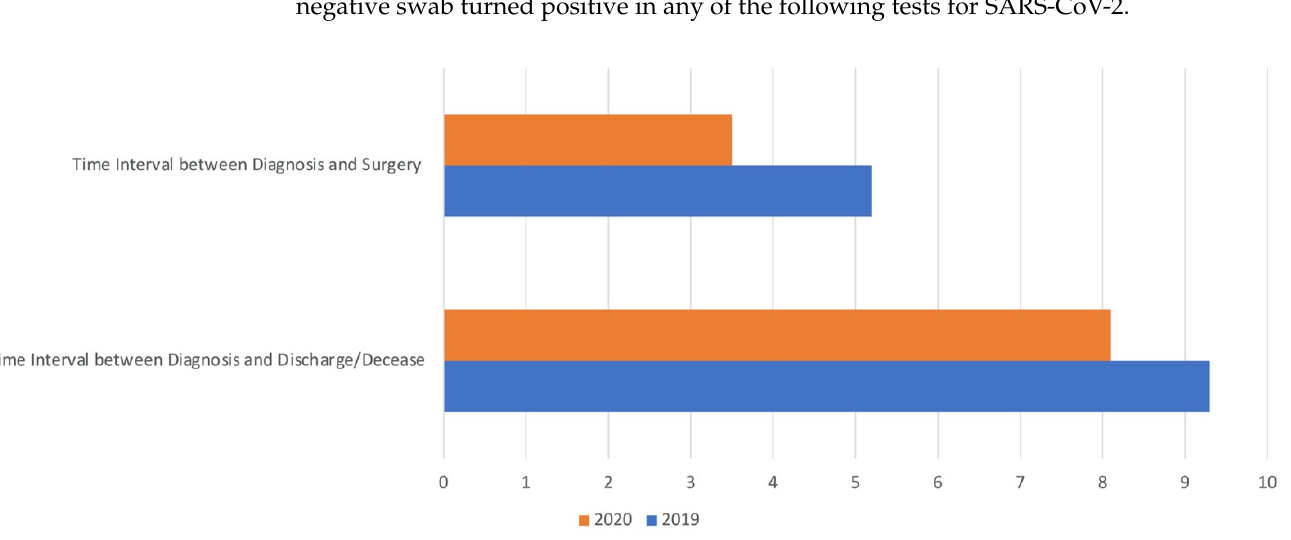
Figure 2. Parameters of effectiveness in health management. Time interval between diagnosis and surgery and between diagnosis and discharge/decease were significantly lower in 2020 (respectively, p -value = 0.0007 and p -value = 0.0284).